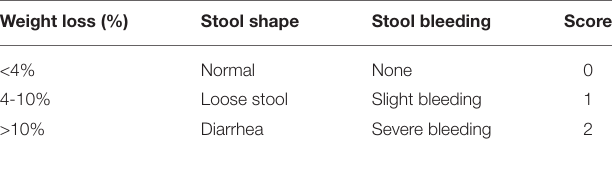
TABLE 1 | The criteria of Disease Activity Index (DAI) score.